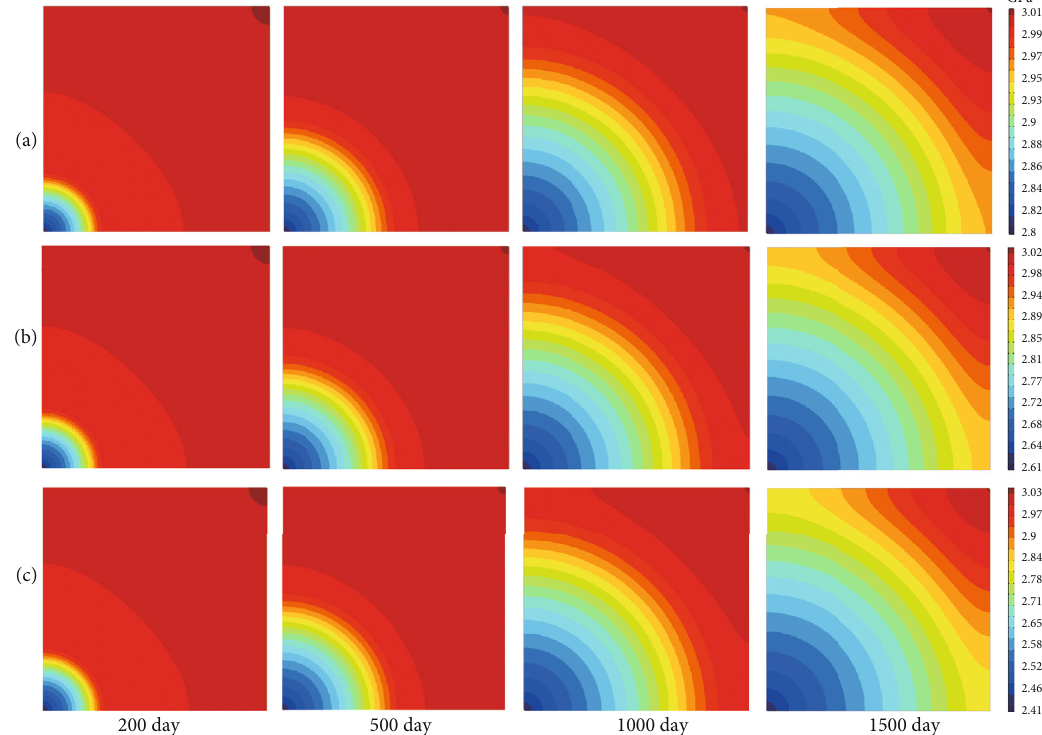
Figure 20: The distribution of elastic modulus in CBM reservoirs during CO2 injection. (a) 10%; (b) 20%; (c)